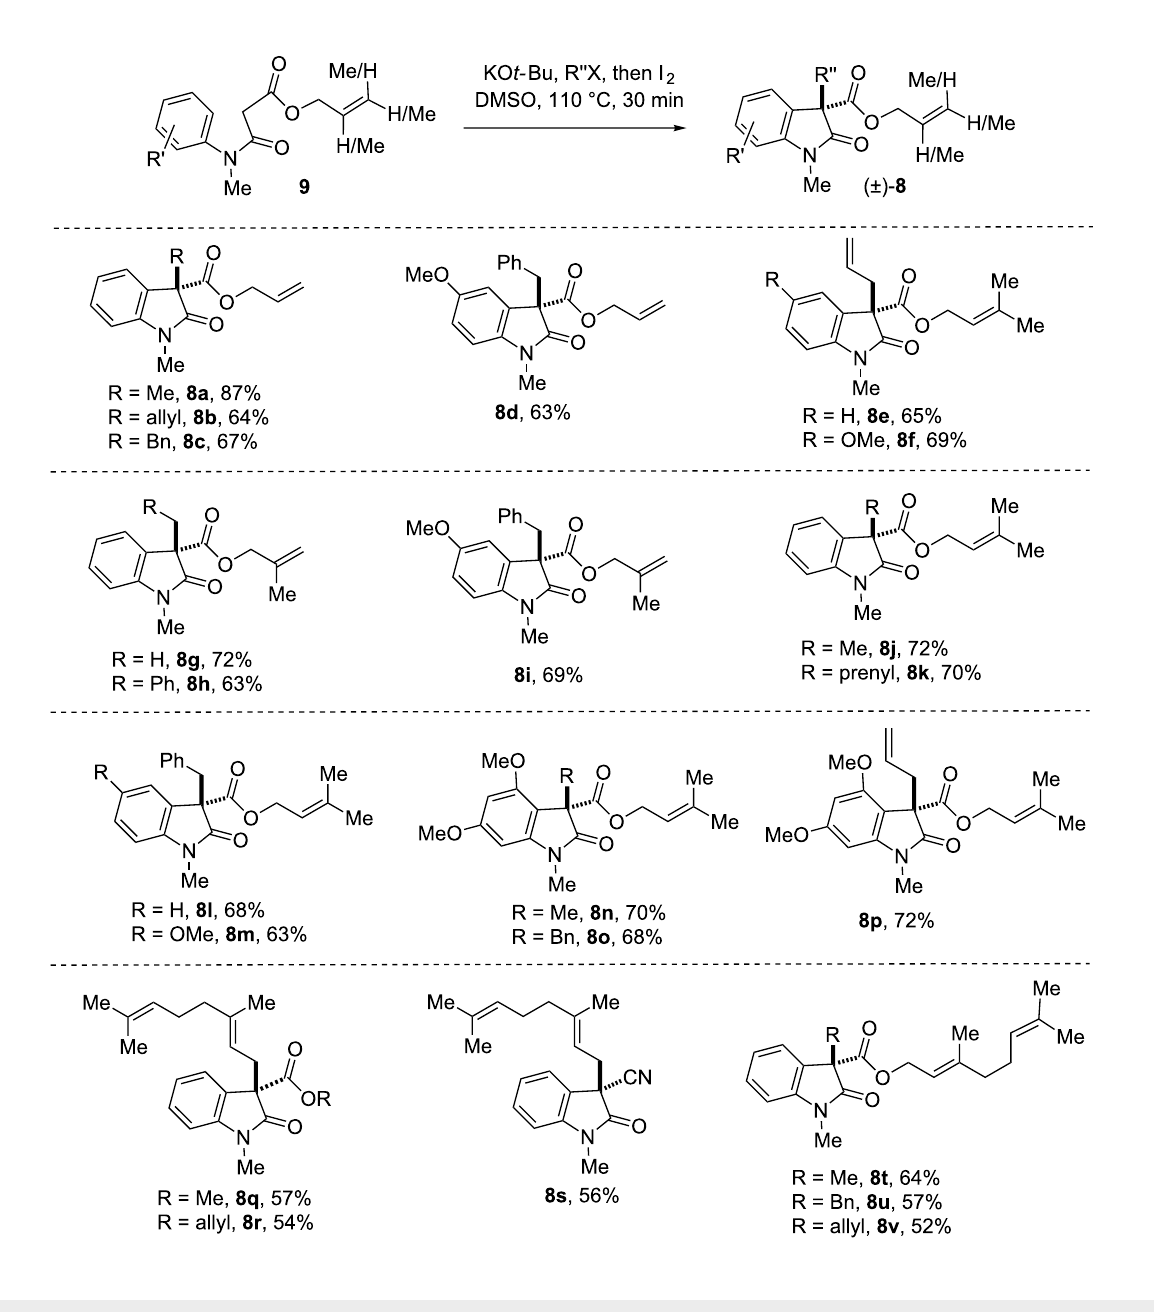
Figure 3: Substrates scope of ‘transition-metal-free’ IDC using KO t -Bu/I 2 . Reproduced from